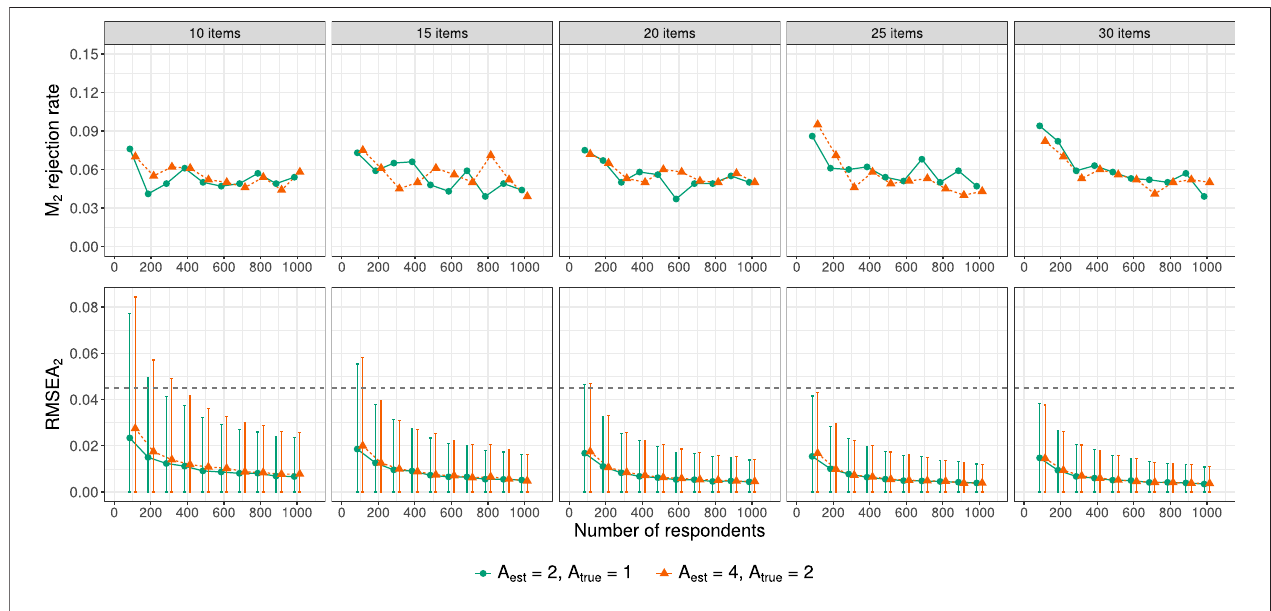
FIGURE 6 | M 2 rejection rates and average RMSEA 2 (with 90% error bars)in the conditions resulting from crossing the number of items I and respondents R for which the estimated model was more fi ne-grained than the generating model ( A est > A true ). Horizontal dashed lines indicate RMSEA 2 of 0.045.